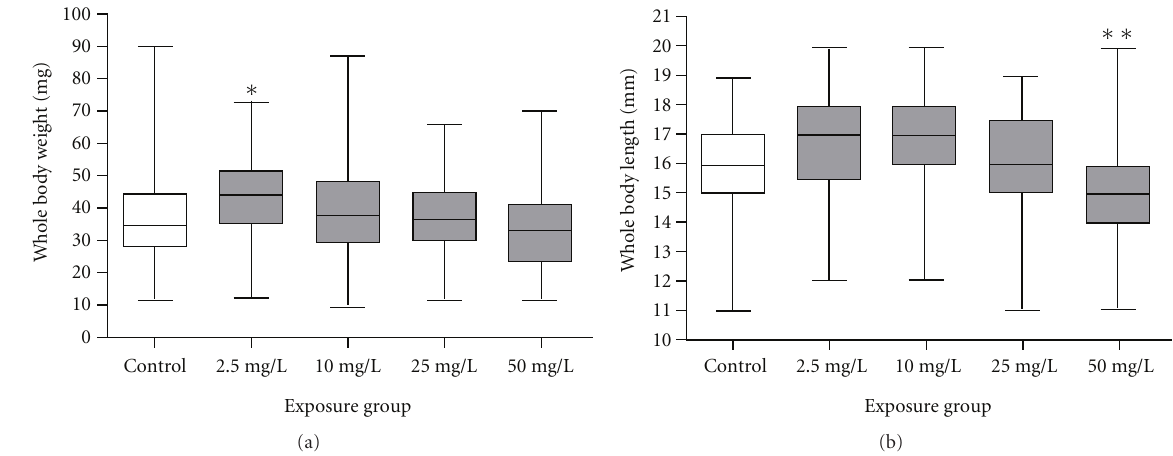
Figure 2: Whole body weight and length of zebrafish ( Danio rerio ) after exposure to 0, 2.5, 10, 25, and 50mg/L PTU. Measurements were performed with 60 animals after 35 days of exposure. Asterisks indicate significant di ff erences between exposure and control groups ( ∗ P < 0 . 05, ∗∗ P < 0 . 01; Dunn’s test).